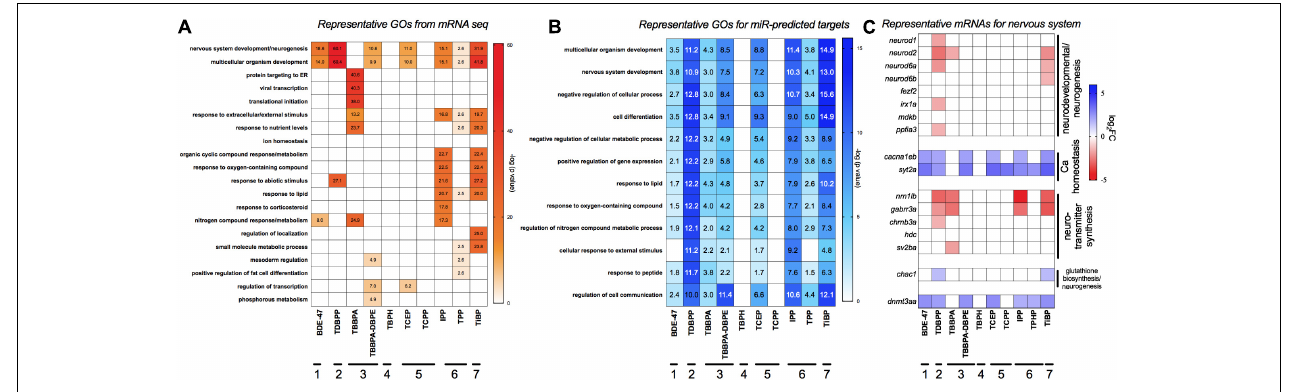
FIGURE 3 | Major gene ontology (GO) processes across FRCs based on (A) differentially expressed mRNAs and (B) target mRNAs of differentially expressed miRs. GO was analyzed using human orthologs within Metacore. For panel (B) , differentially expressed miRs were imported into TFmiR and both experimentally validated, and computationally predicted gene targets were imported into Metacore for GO analysis. Data is represented as -log (FDR p value) for each term; a value of ∼ 1.3 represents FDR p threshold of 0.05. Numbers within cells represent the significant -log (FDR p value). (C) Expression of representative mRNAs known to regulate nervous system development and neurotransmitter activity. Horizontal lines with numbers (1–7) represent FRC class based on Figure 1